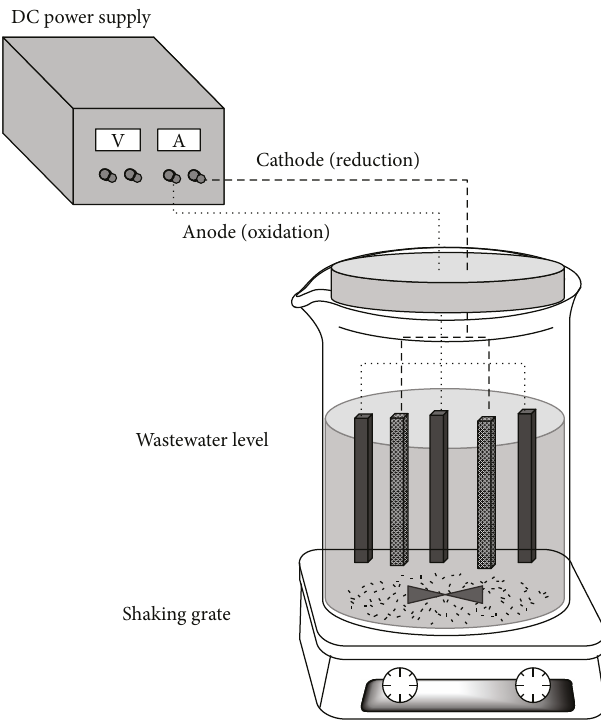
Figure 1: A schematic diagram of the electrochemical reactor. Table 2: Experimental design of the electrooxidation